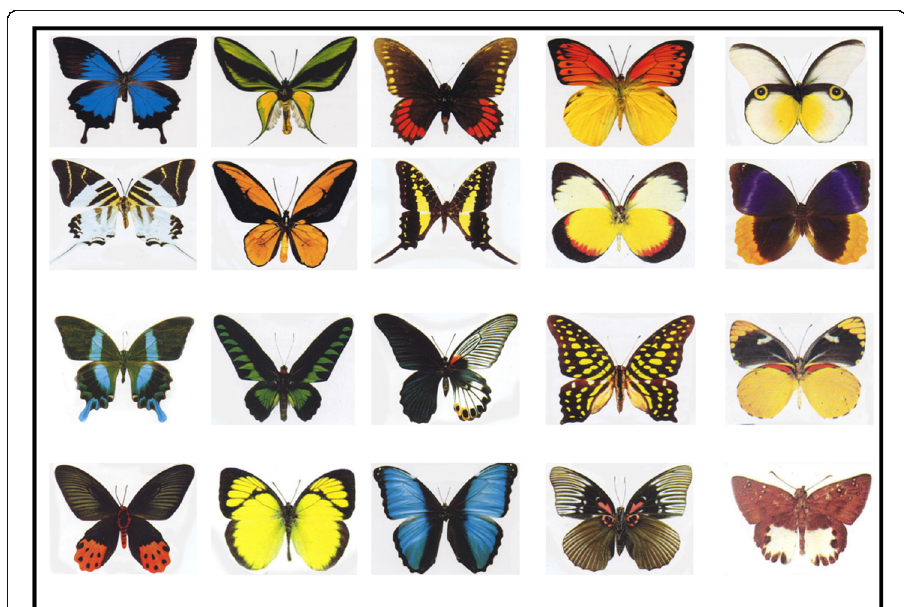
Fig. 11 Some sample images in the Butterfly color image